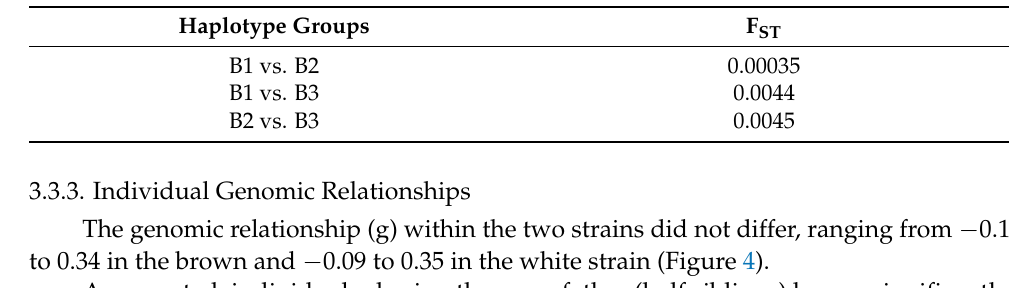
Table 5. F ST values calculated between individuals with different mt haplotypes.